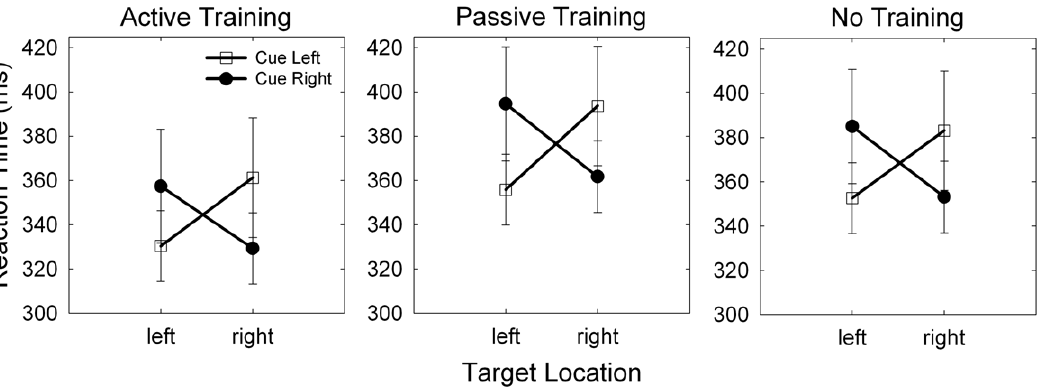
Figure 5. Reaction time (RT; ms) as a function of cue location, target location and training condition. RT was lower when the target appeared in the cued location than in the uncued location, p , .001 [61]. This effect did not interact with training condition (p=.861) or tool location (p=.145). Error bars represent 95% confidence intervals.